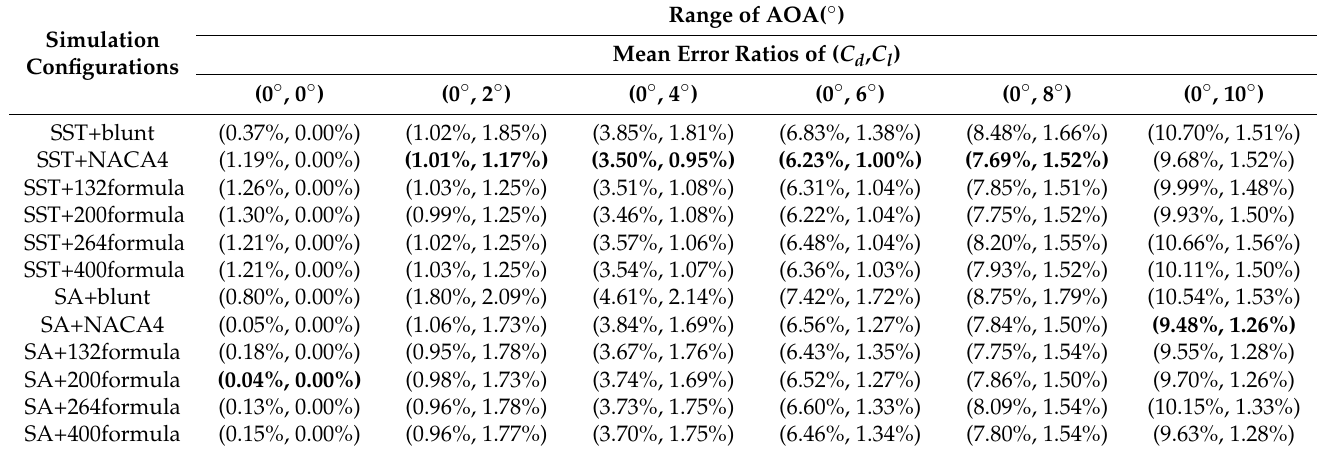
Table 14. The mean error ratios of C d and C l of 12 m far-field distance.